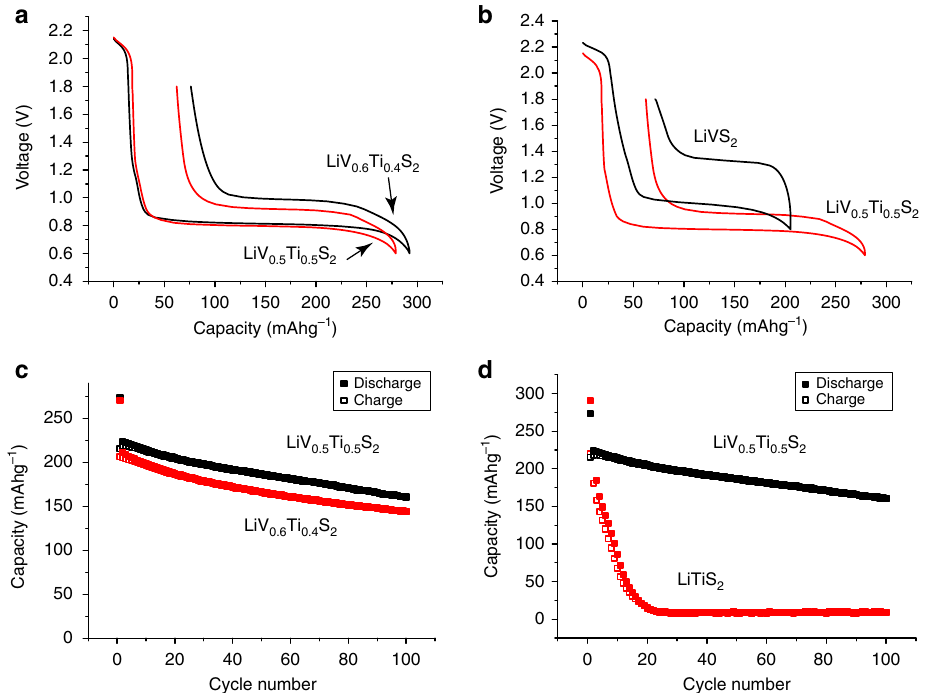
Figure 2 | Comparisons between Li(V 0.5 Ti 0.5 )S 2 and other members of the Li(V 1- x Ti x )S 2 solid solution. ( a , b ) show the variation of potential with state-of-charge on the 1st cycle for